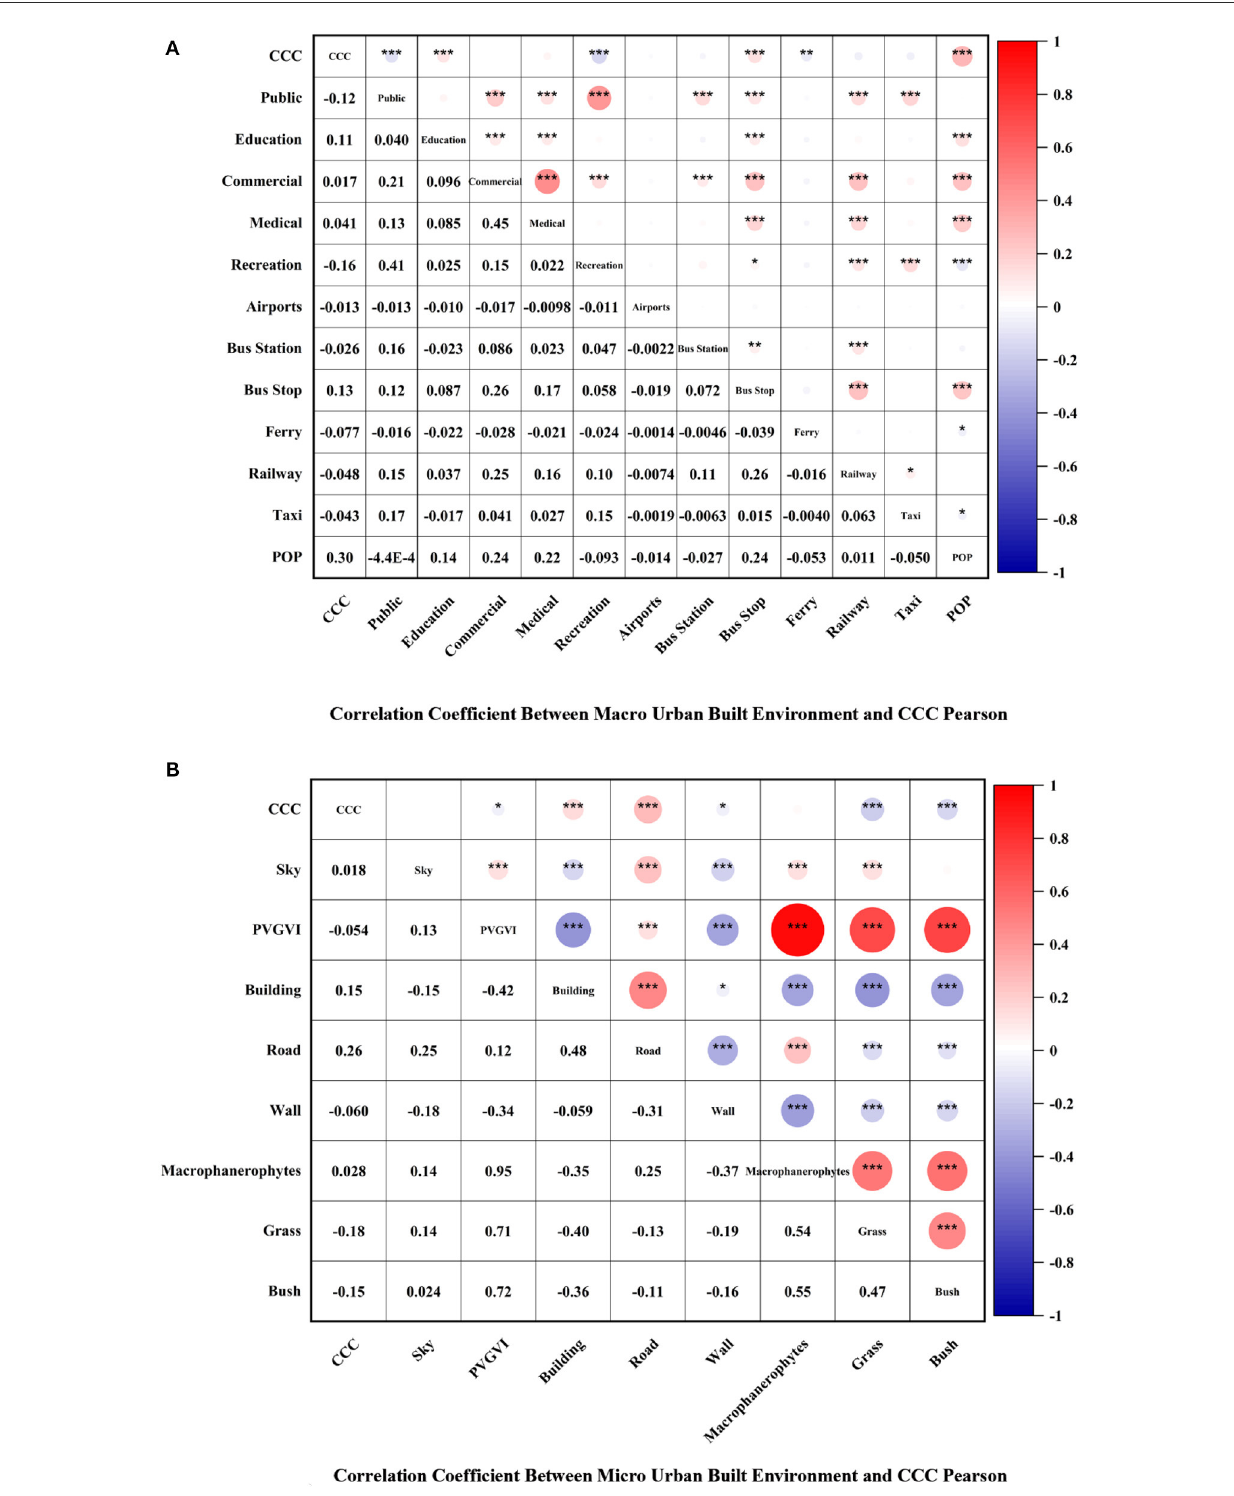
FIGURE6 Correlation coefficient between urban built environment and CCC Pearson. (A) Correlation coefficient between macro urban built environment and CCC Pearson. (B) Correlation coefficient between micro urban built environment and CCC Pearson. * p < 0.05, ** p < 0.01, *** p <